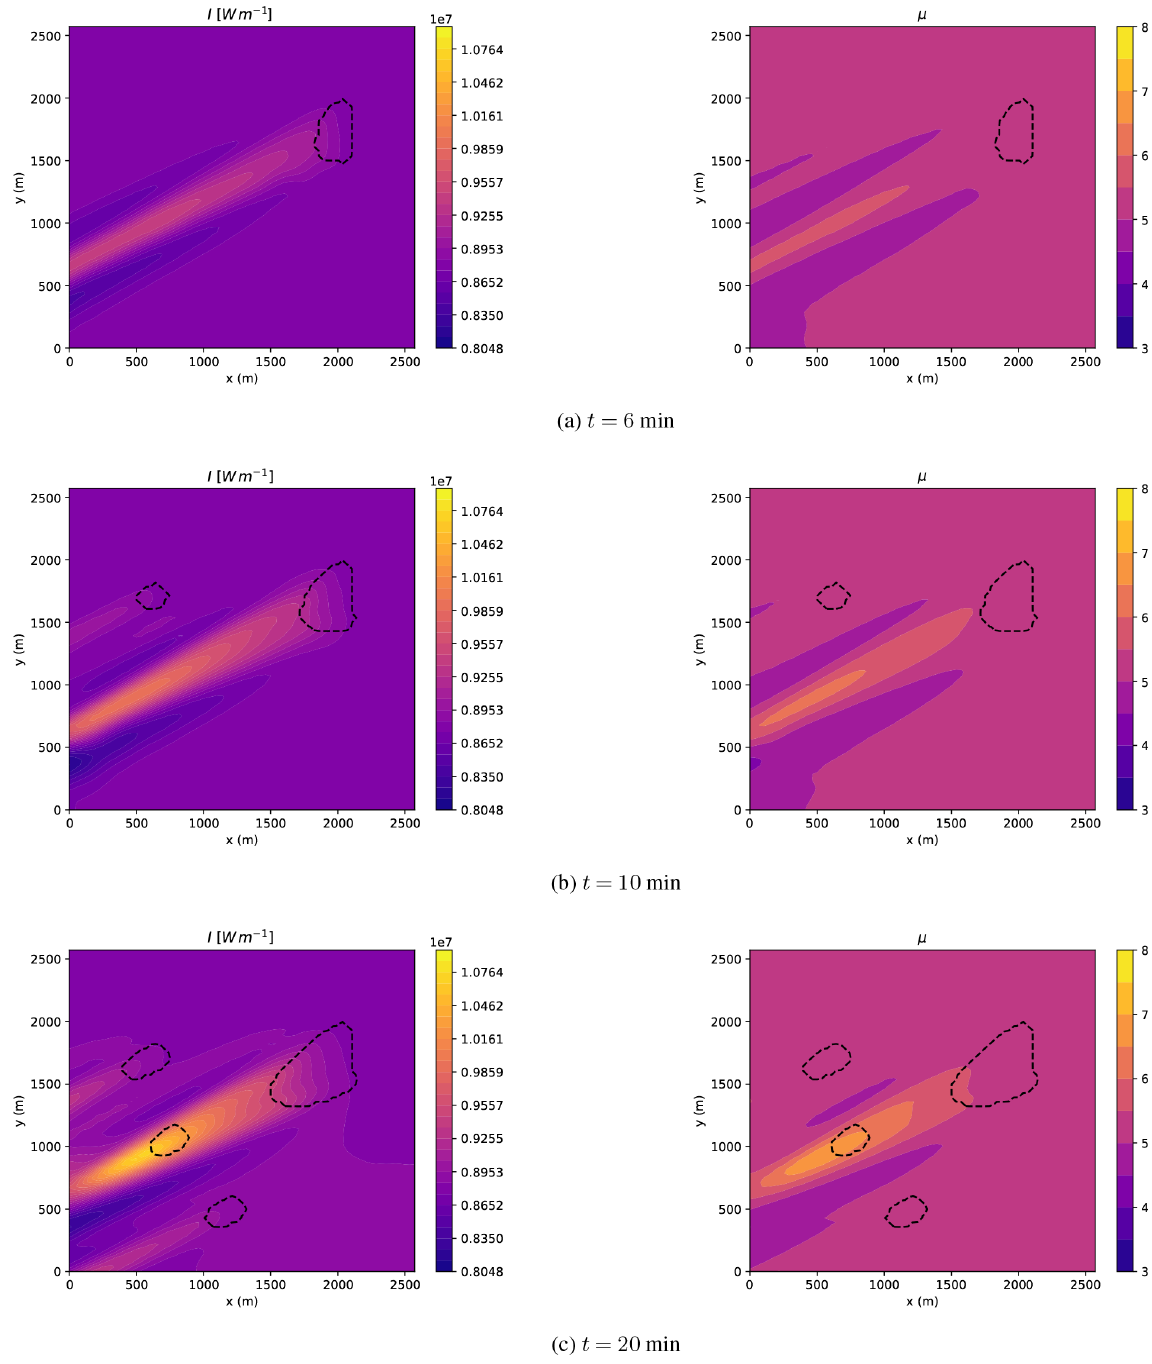
Figure 2. Fire intensity I and PDF shape parameter µ performed with WRF-SFIRE at times t = 6, 10 and 20min. The fire front is represented by a dashed